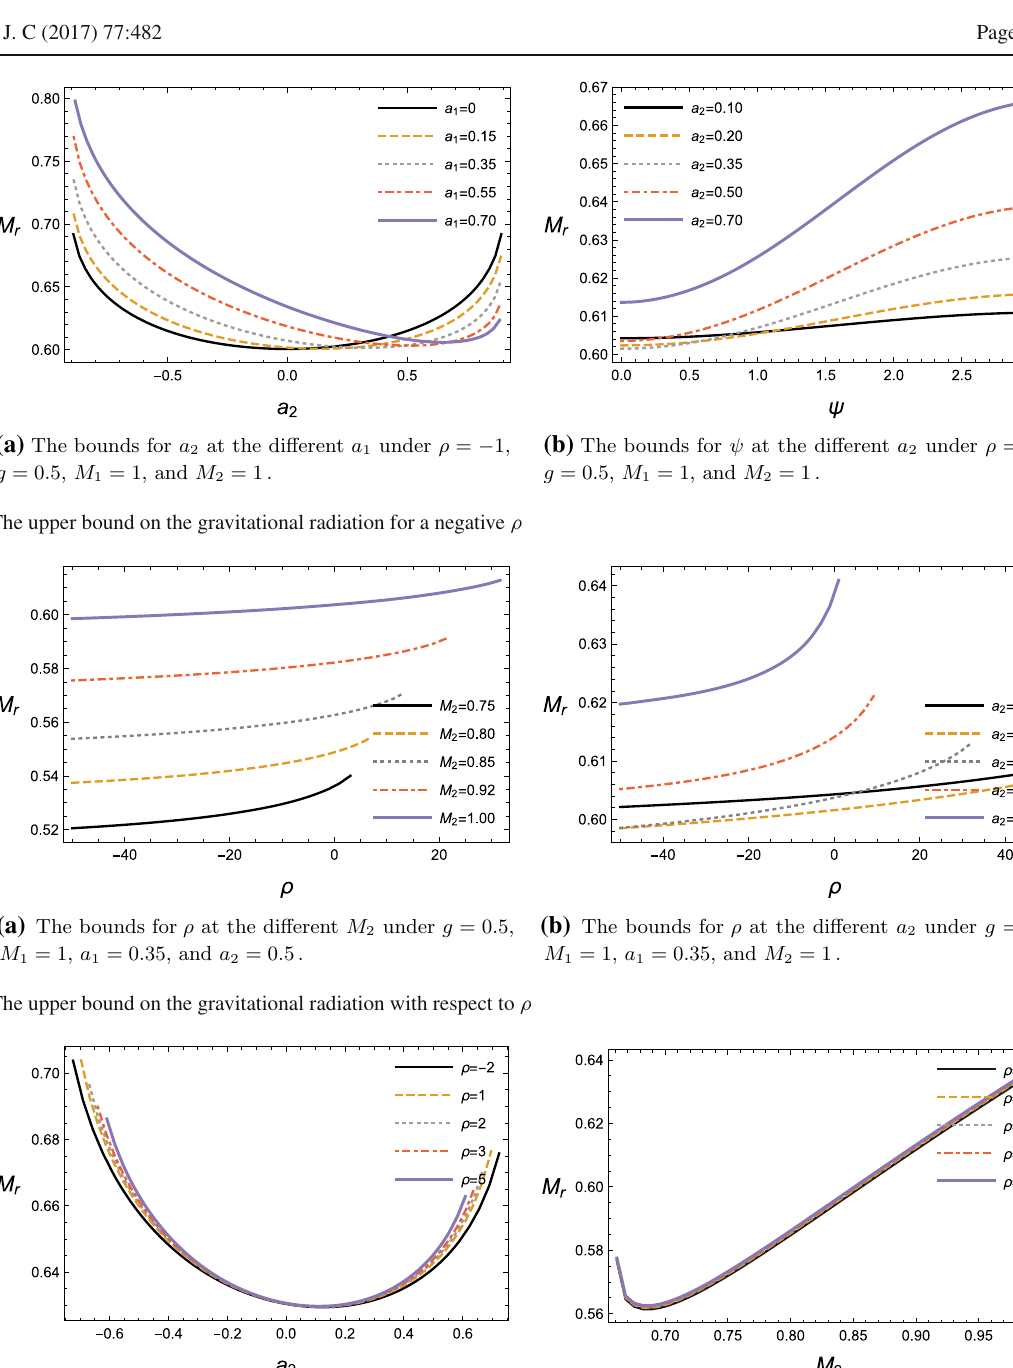
( a ) The bounds on the radiation for g = 0 . 7, M 1 = 1, a 1 = 0 . 15, and M 2 = 1. Fig. 12 The upper bound on the gravitational radiation with respect to